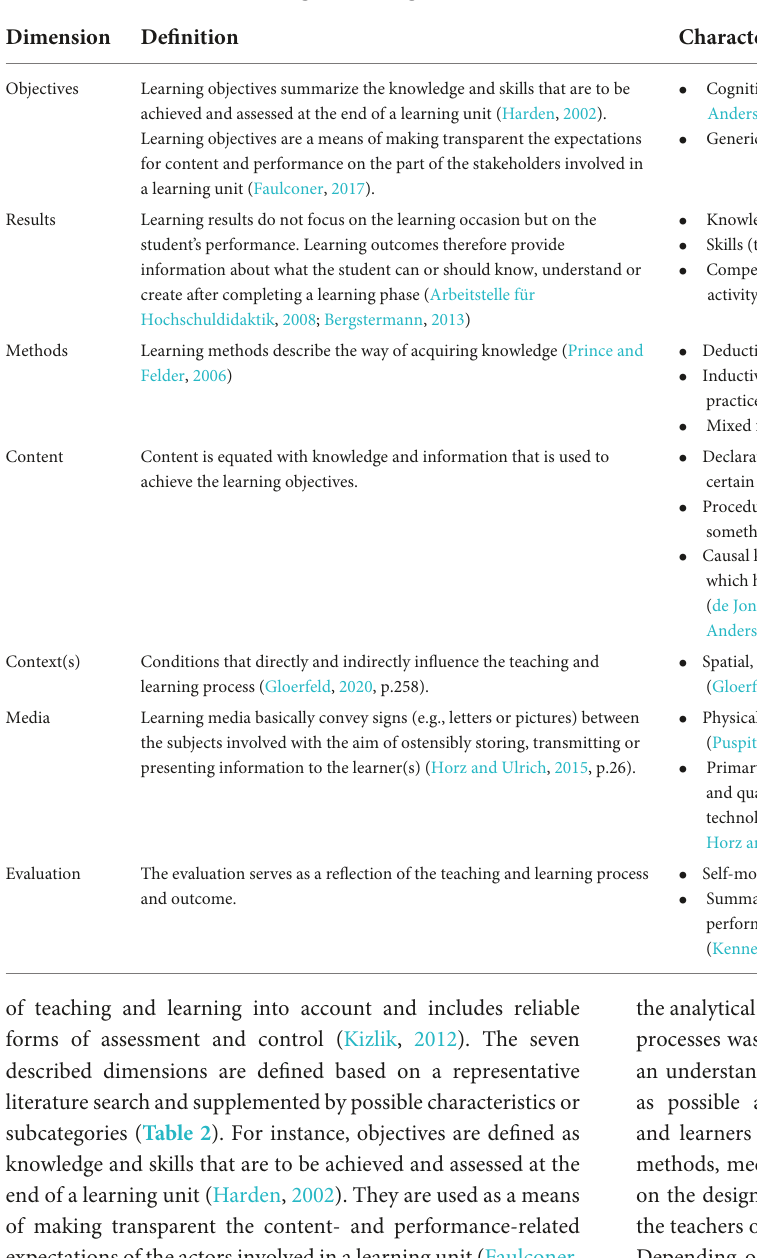
TABLE 2 The dimensions of teaching and learning and their